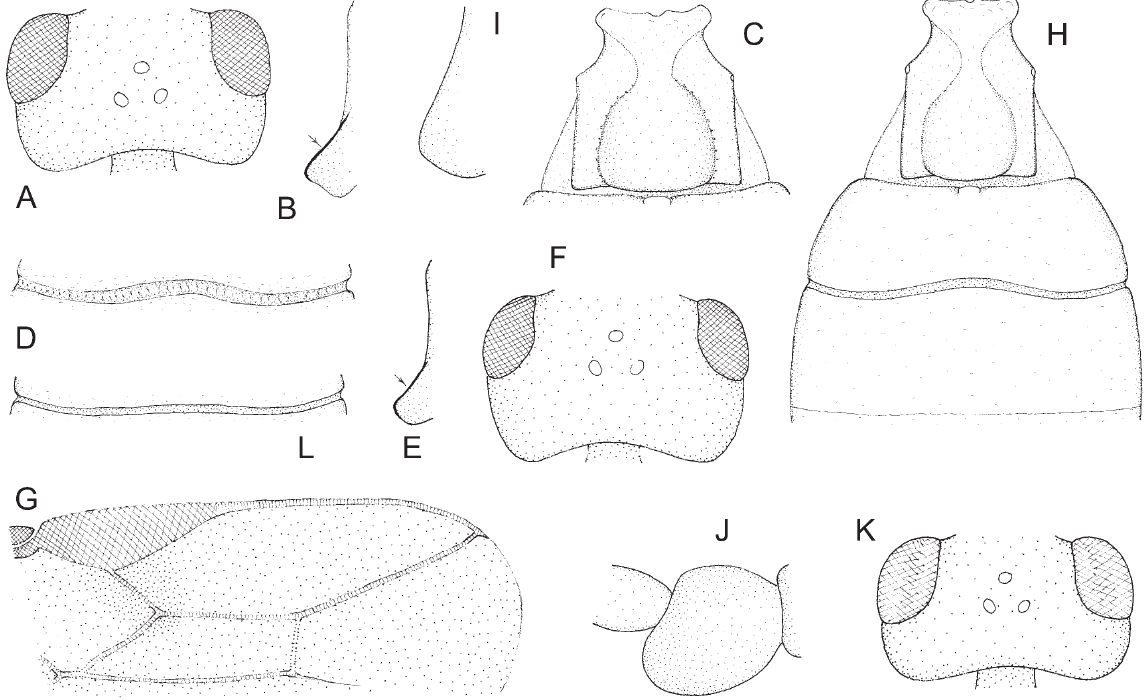
Fig. 41. — A-D . Bracon ( Pigeria ) piger Wesmael, 1838, ♀ / ♂. A . Head in dorsal view. B . Propleuron in lateral view. C . First tergite. D . Suture between tergites 2-3. — E-H . Bracon ( Pigeria ) wolschrijni van Achterberg, 1985, ♀ / ♂. E . Propleuron in lateral view. F . Head in dorsal view. G . Distal part of right forewing. H . Tergites 1-3. — I-L . Bracon ( Glabrobracon ) variator Nees, 1811, ♀ / ♂. I . Propleuron in lateral view. J . Fore coxa in lateral view. K . Head in dorsal view. L . Suture between tergites